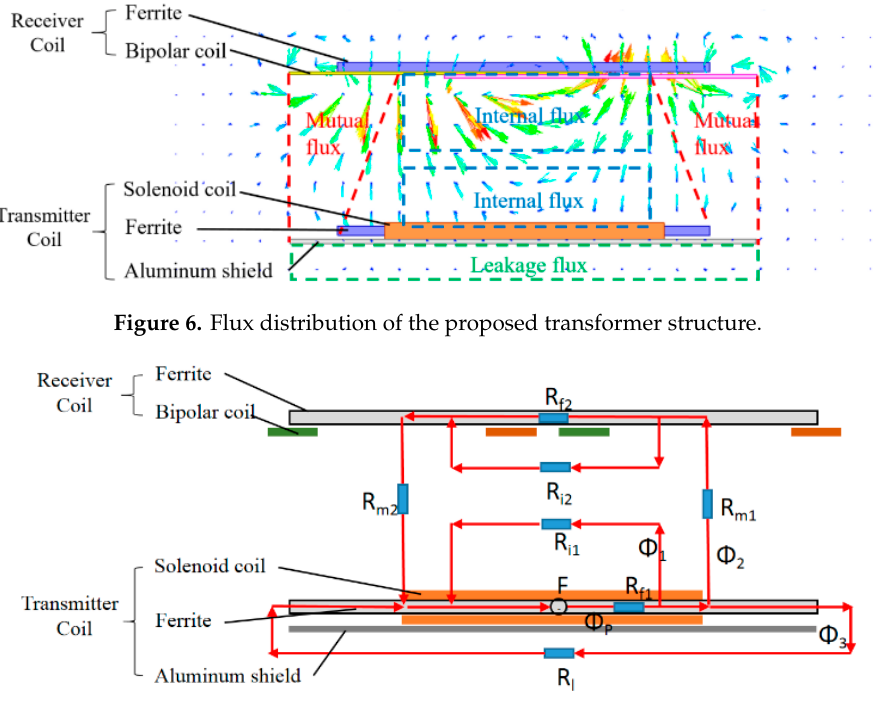
Figure 7. Equivalent magnetic reluctance network.